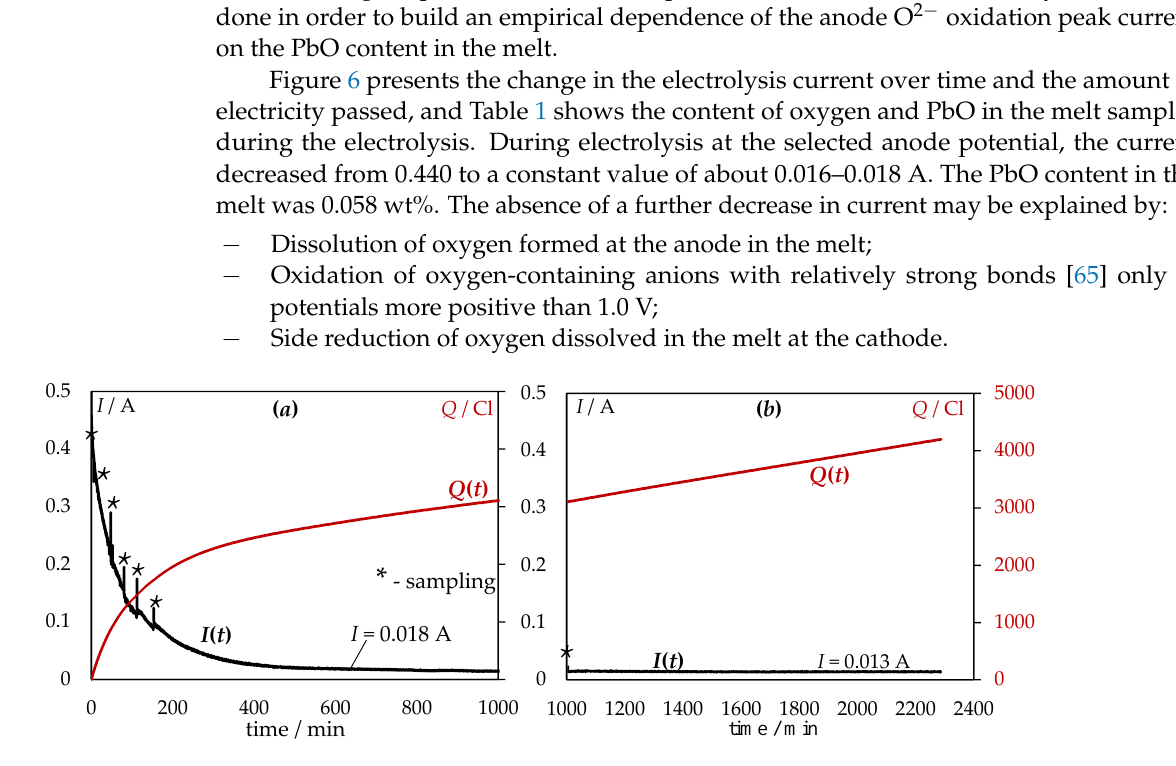
Figure 6. Change in current and amount of electricity passed during the electrolysis of the PbCl 2